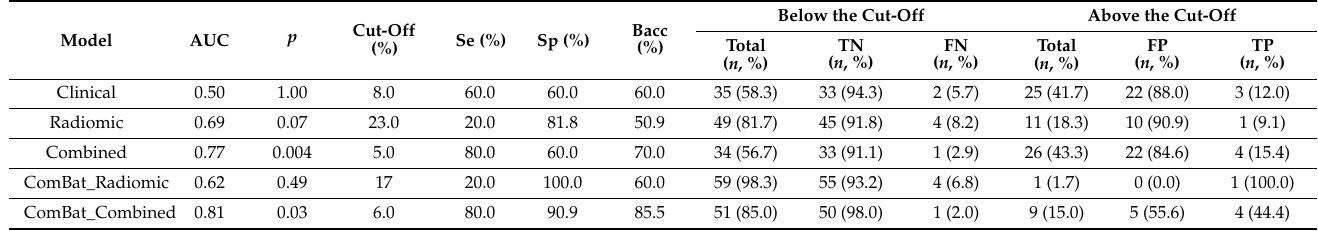
Table 3. Results of each model in the testing cohort (institution 2).